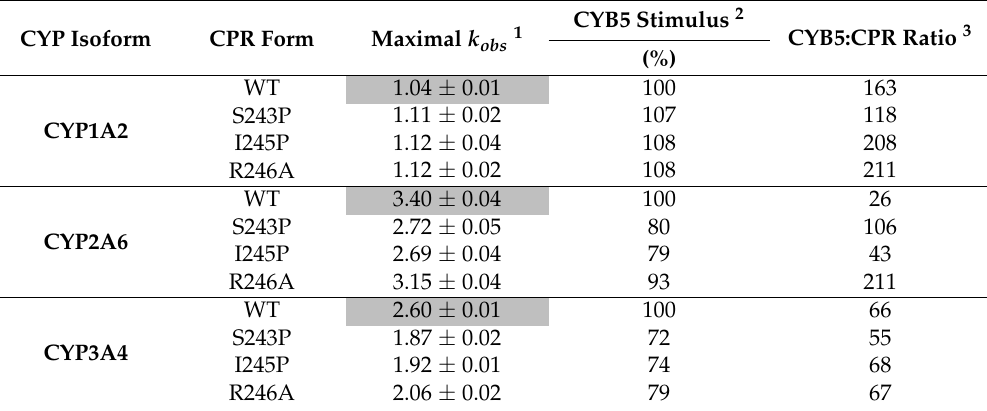
1 Normalized maximum enzyme activity: ( k obs )/( k obs at 0 nM CYB5). Values are expressed as the mean of three independent experiments ± sd. 2 Maximum CYB5 stimulus of enzyme activity when CYPs were combined with mutant CPRs, relative to the ones obtained with CPR WT. 3 The ratio at which maximum k obs was reached. Grey shaded values: Maximum fold stimulation of enzyme activity by CYB5 when CYPs were combined with WT